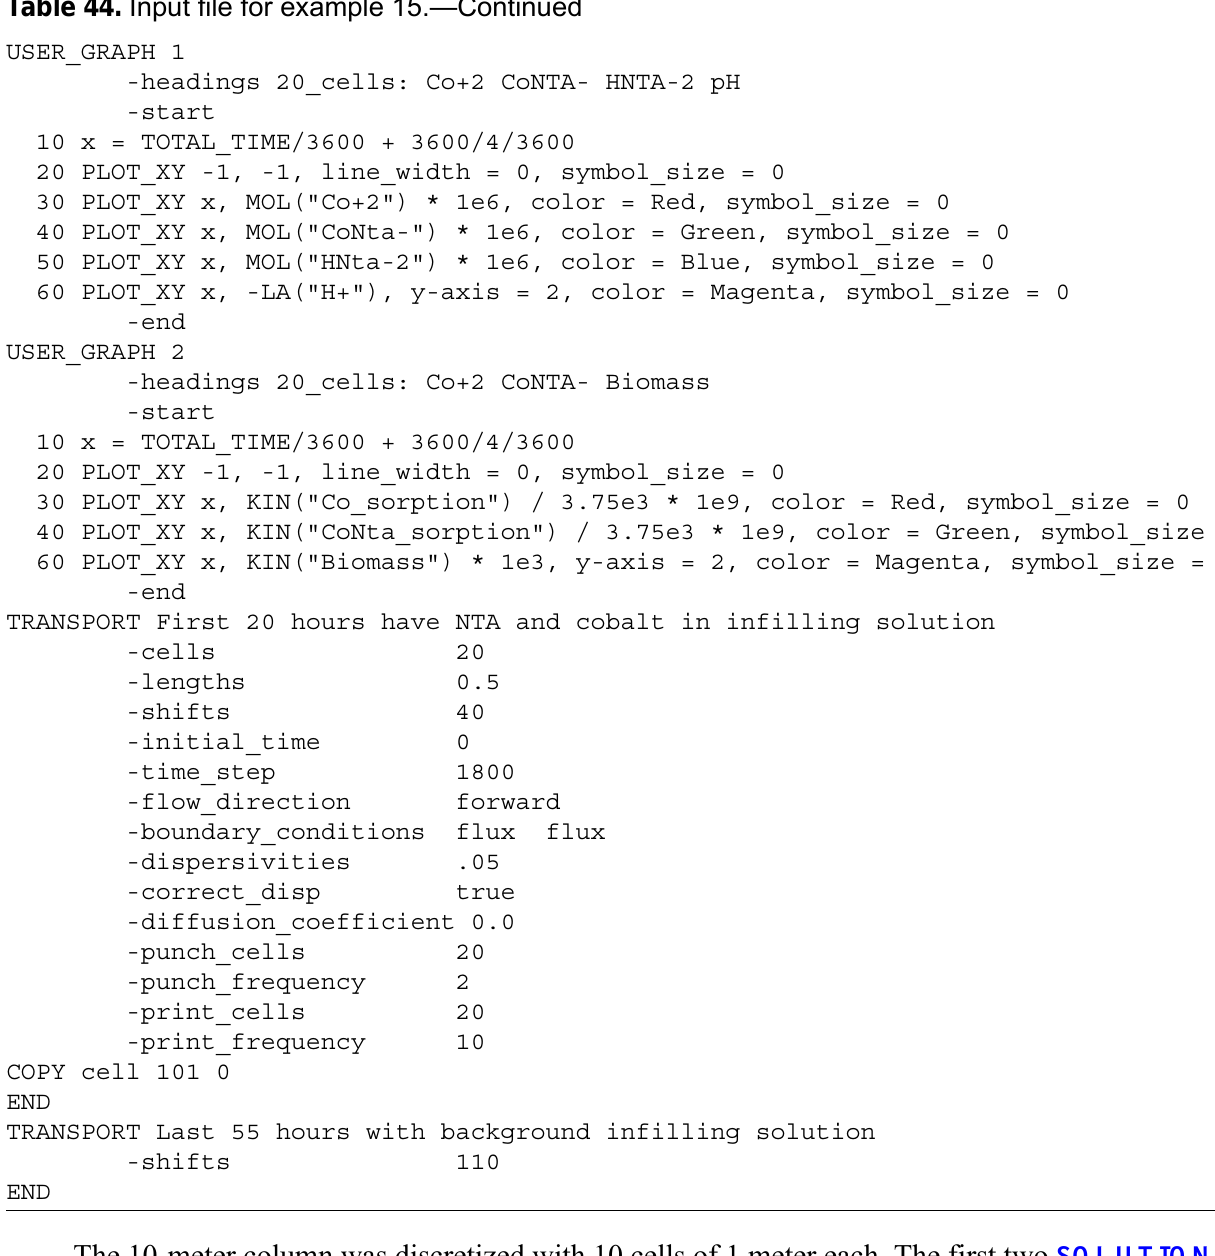
Table 44. Input file for example